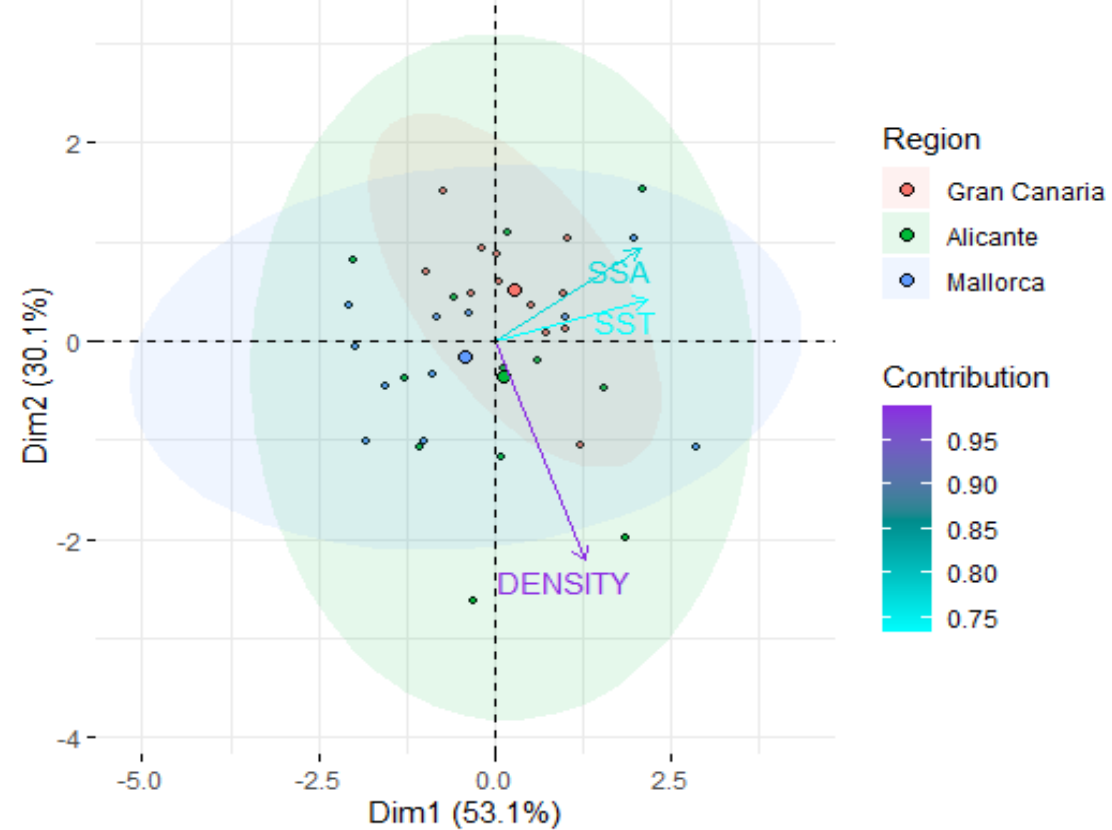
Figure 3. Redundancy Analysis (RDA) examining differences in meadows according to ocean climate and seagrass habitat structure. SSA: seagrass surface area (cm 2 ), SST: mean seasonal sea surface temperature (°C), and DENSITY: seagrass shoot density (shoots m − 2 ). The colors of the arrows indicate their contribution relative to the variance explained by the axis, and the colors of the different circles represent meadows from each region. Centroids for each region are depicted by large-size dots. Ellipsoids show confidence limits (0.95) in areas encompassing meadows from each region.